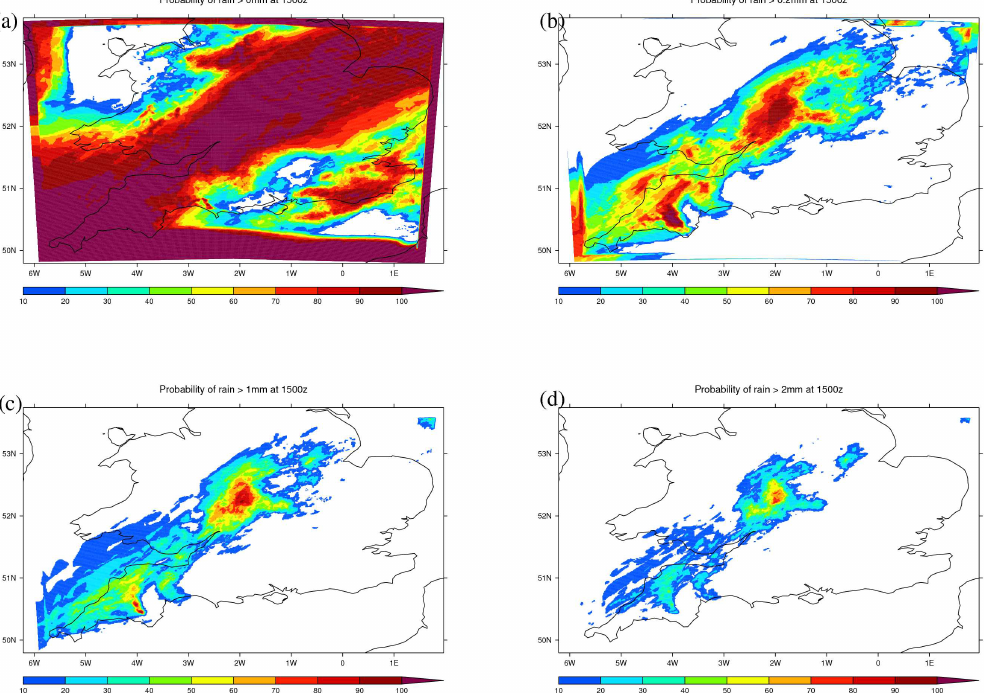
Fig. 12. Probability of rain rate exceeding given thresholds (%) for the control ensemble at 15:00UTC. Thresholds are (a) 0mm, (b) 0.2mm, (c) 1mm and (d)